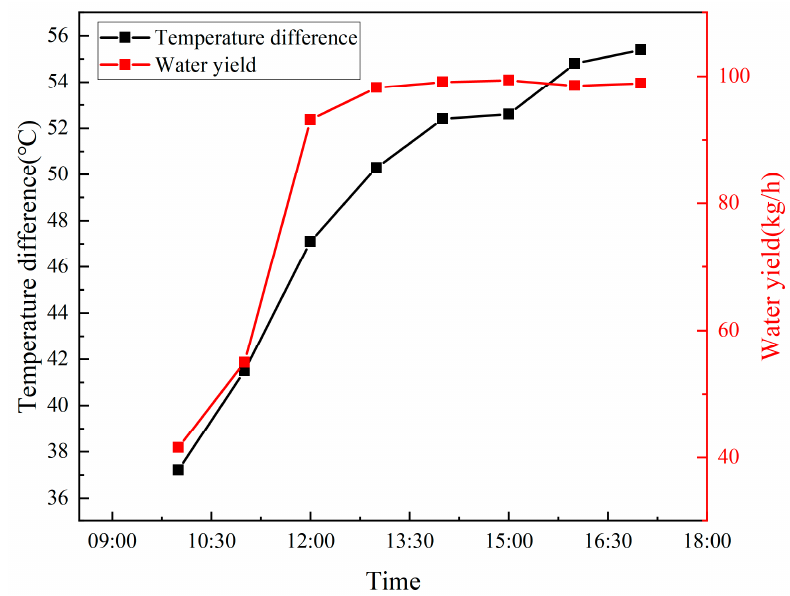
Figure 24. The temperature difference between the feed seawater and the water tank with the water production rate over time.